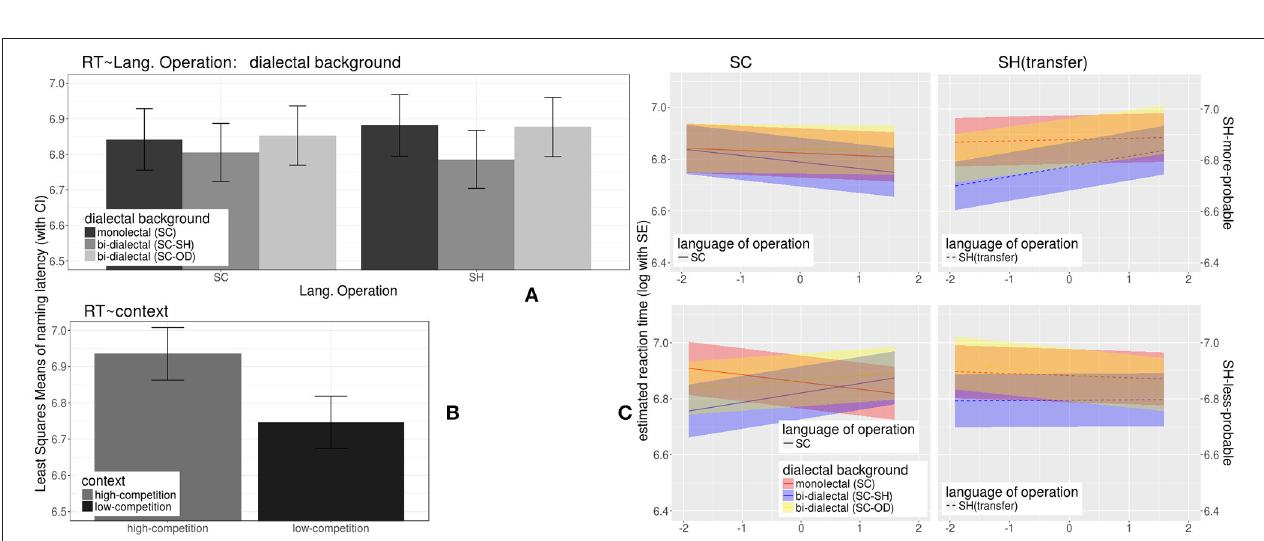
FIGURE 5 | Effects on mean accuracy rates in response to word trials during lexical identification test, including (1) effects of dialectal background (color) and context provided by the distractor (cluster), in SC (A) (left panel) and SH (B) (middle panel), (2) the effect of age (C) (upper right panel), and (3) the interaction between subjective cross-dialectal similarity and semantic concreteness (D) (lower right panel).